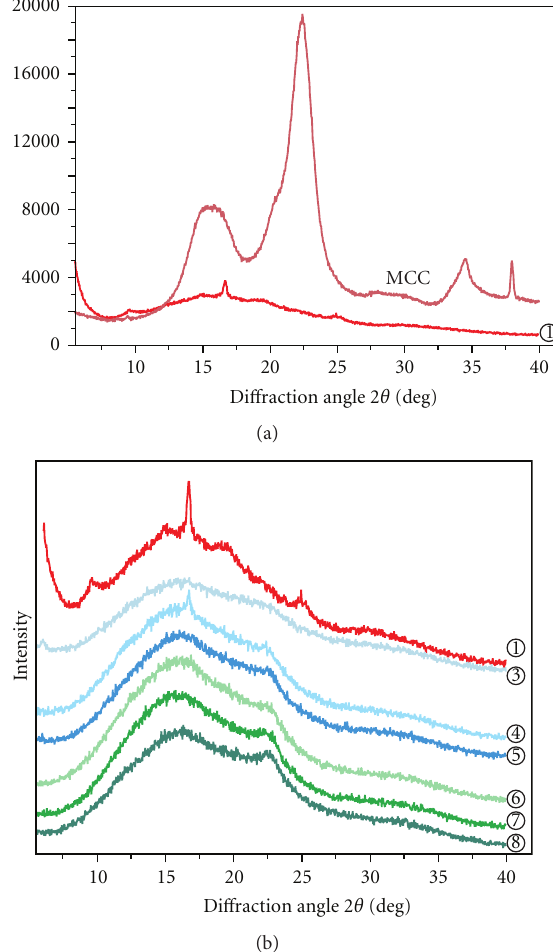
F 10: Diffraction patterns of MCC, neat PLA, and PLA-based